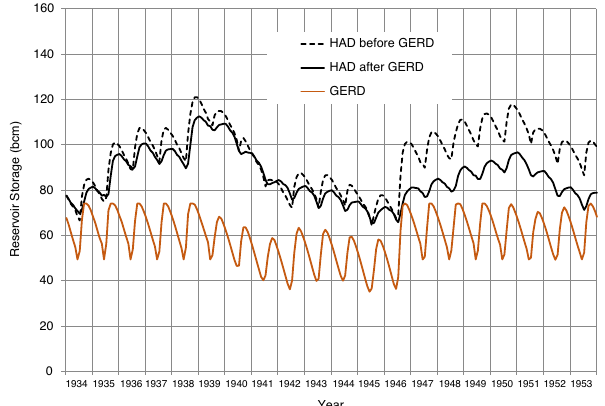
Fig. 6 New normal conditions with the GERD under a historically average 20-year sequence. Storage volumes for the GERD and HAD are